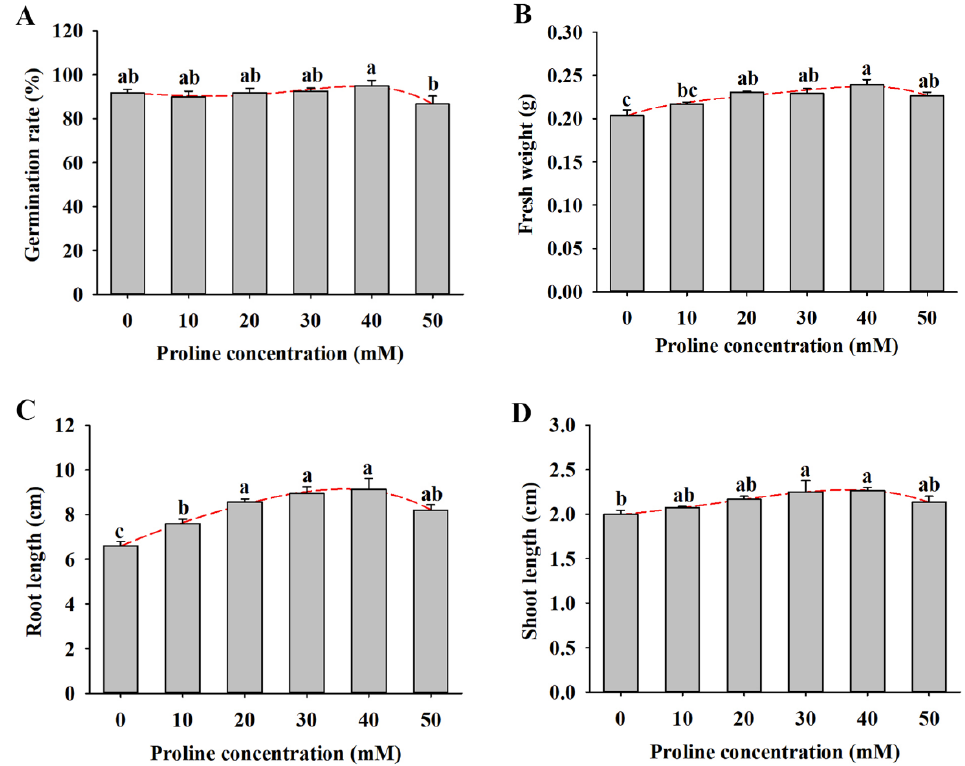
Figure 1. Seed germination and seedling growth of alfalfa under different concentrations of proline (0, 10, 20, 30, 40, and 50 mM) for 14 d. (A) Germination rate. (B) Fresh weight. (C) Root length. (D) Shoot length. Data are means ± SE ( n = 40), and different letters indicate significant differences between groups ( p < 0.05).